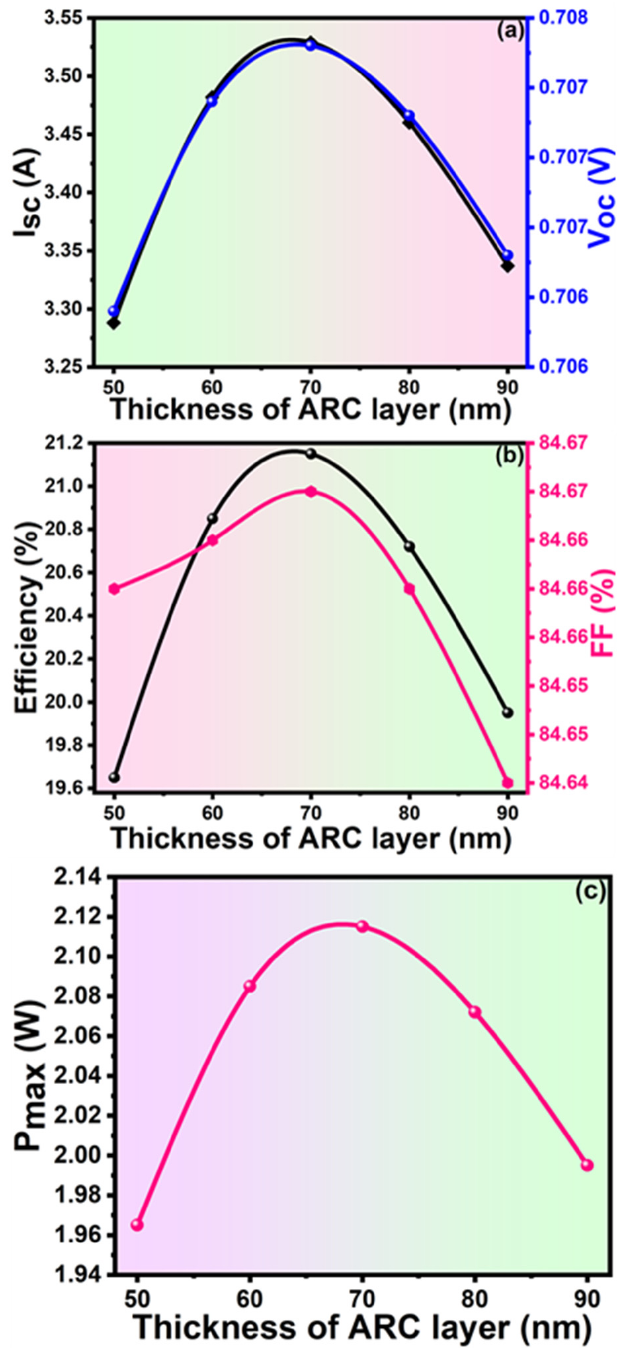
Figure 9. Plots of ( a ) I sc & V oc ( b ) PCE & FF ( c ) Pmax with a thickness of ARC layer-based c-Si solar cell.